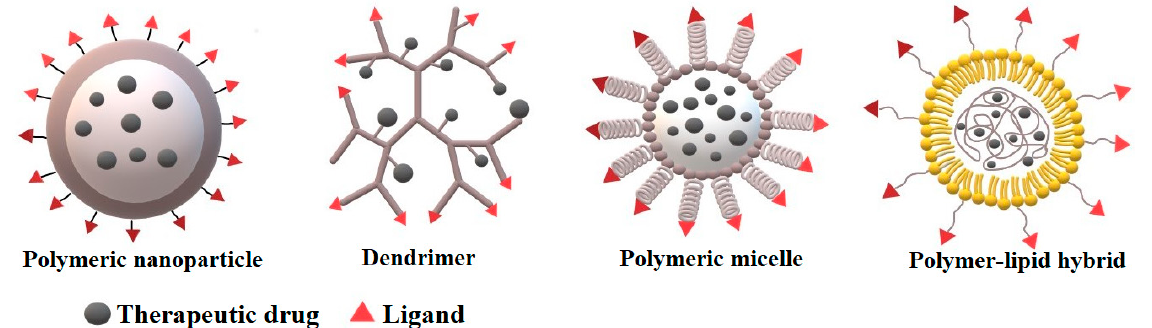
Figure 2. The different types of polymer nanocarriers for drug delivery. Dendrimers represent an attractive hyperbranched 3D object for biomedicine. Their greatest advantage is the ability to have multiple functional groups on their